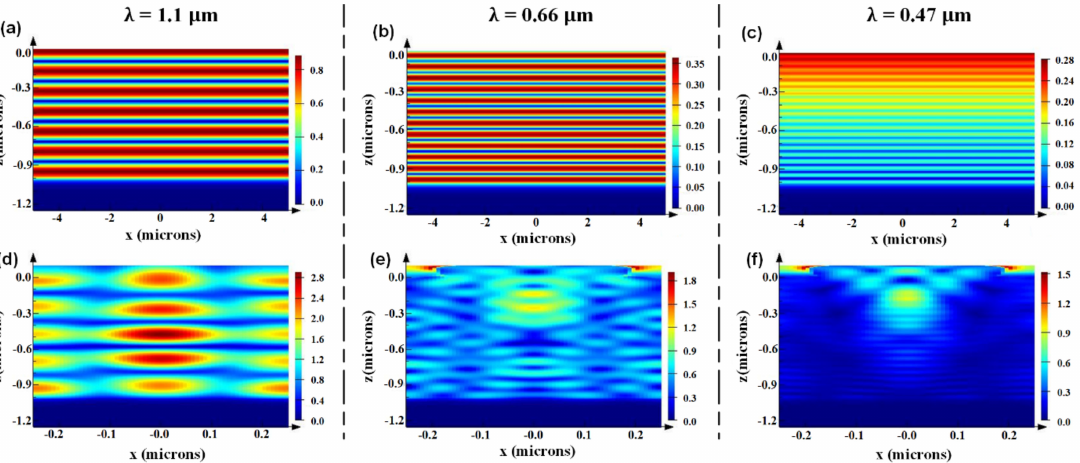
Figure 6. At normal incidence, the electric field distribution |E| at the X-Z cut of the plane solar cell for ( a – c ), CSNP solar cell for ( d – f ). The wavelengths are fixed at 1.1 µ m, 0.66 µ m and 0.47 µ m (from left to